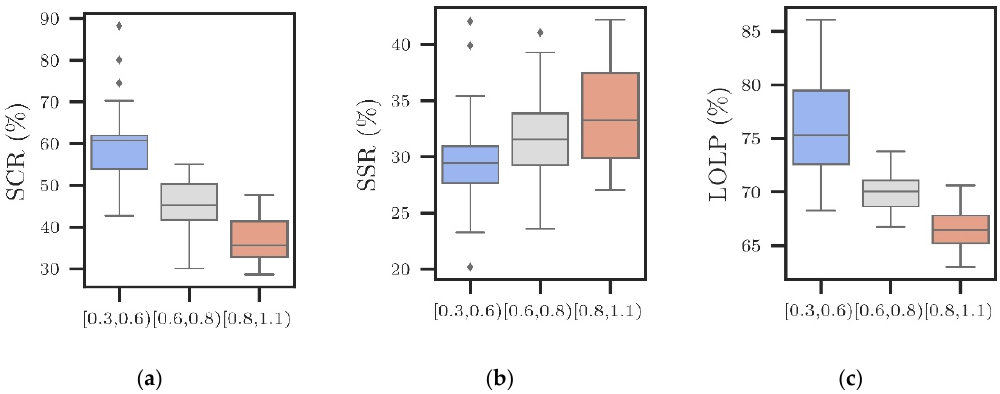
Figure 7. Load matching indicator values for di ff erent ranges of the generation-to-demand ratio GTDR;